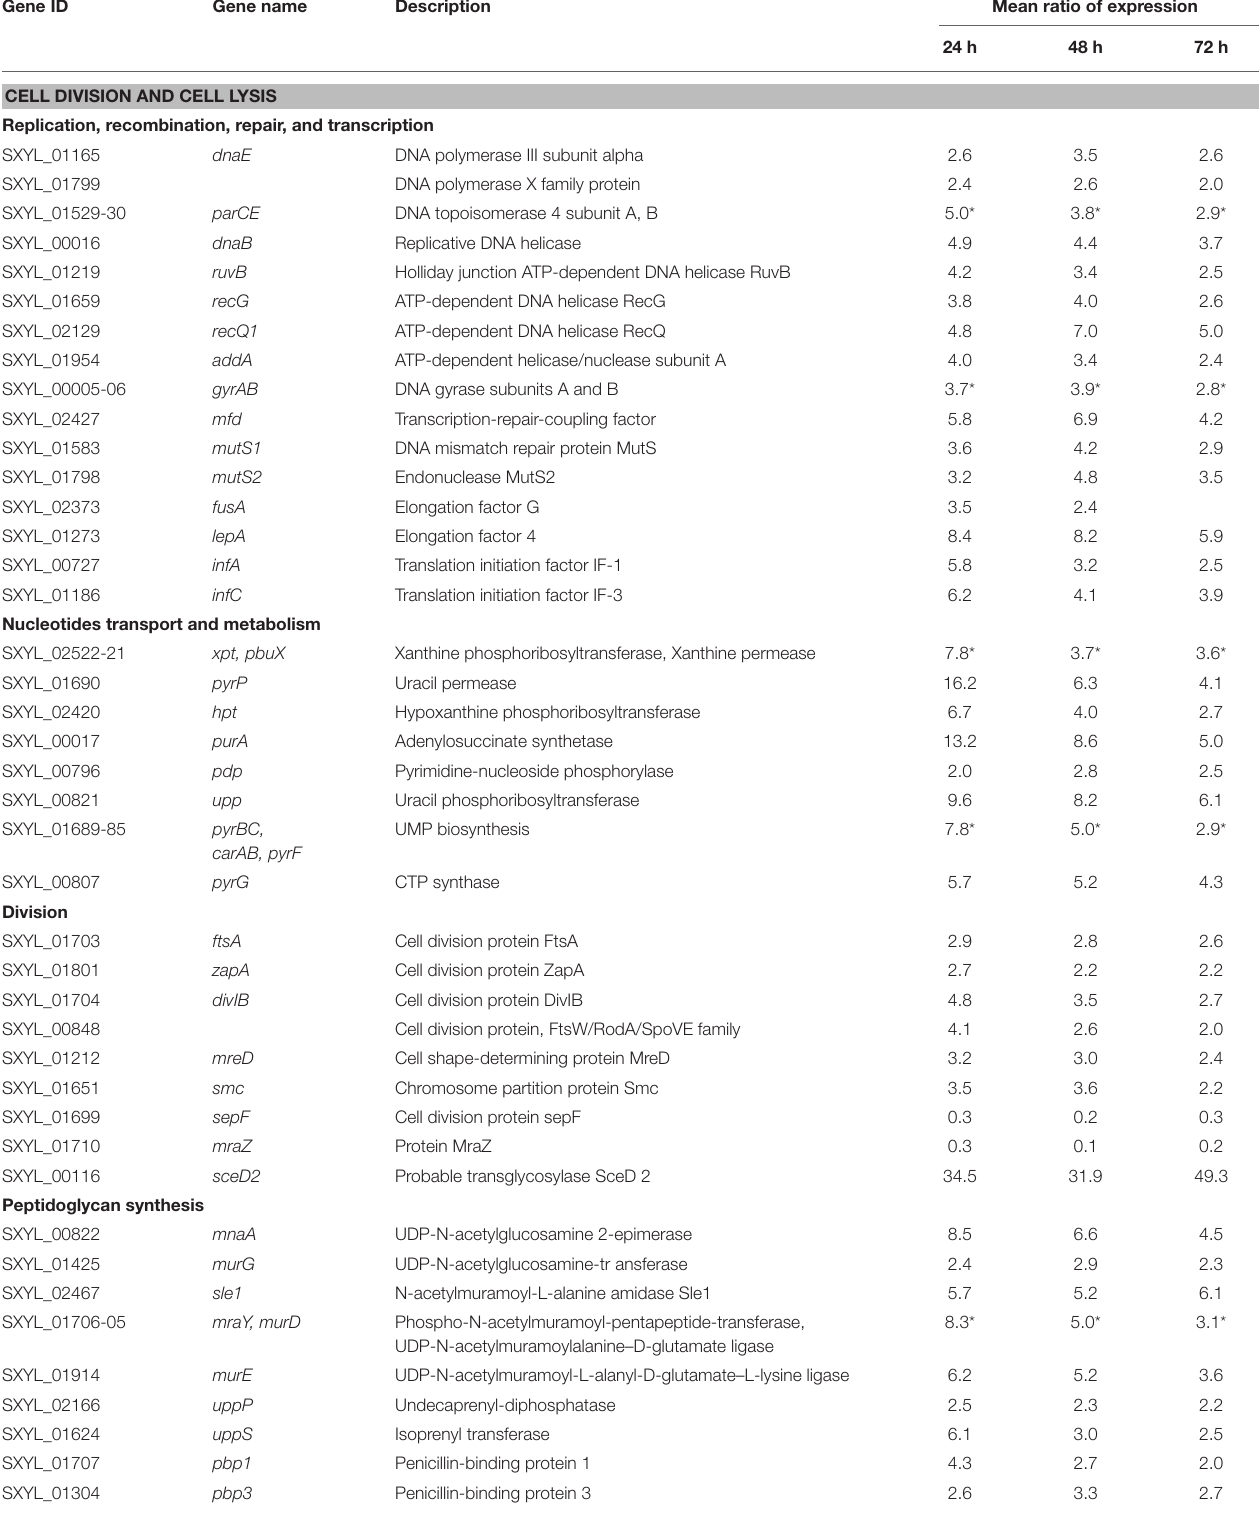
TABLE 1 | Genes of Staphylococcus xylosus discussed in this study differentially expressed over time in meat. Gene